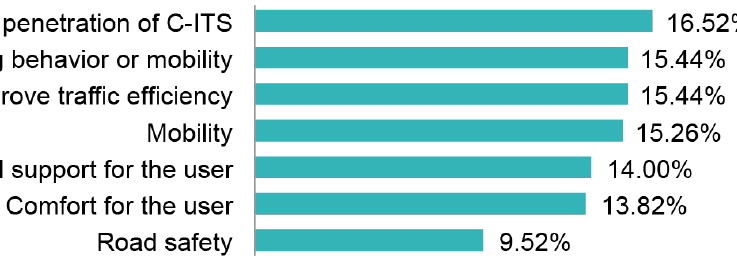
Figure 20. Expected impacts of the system.